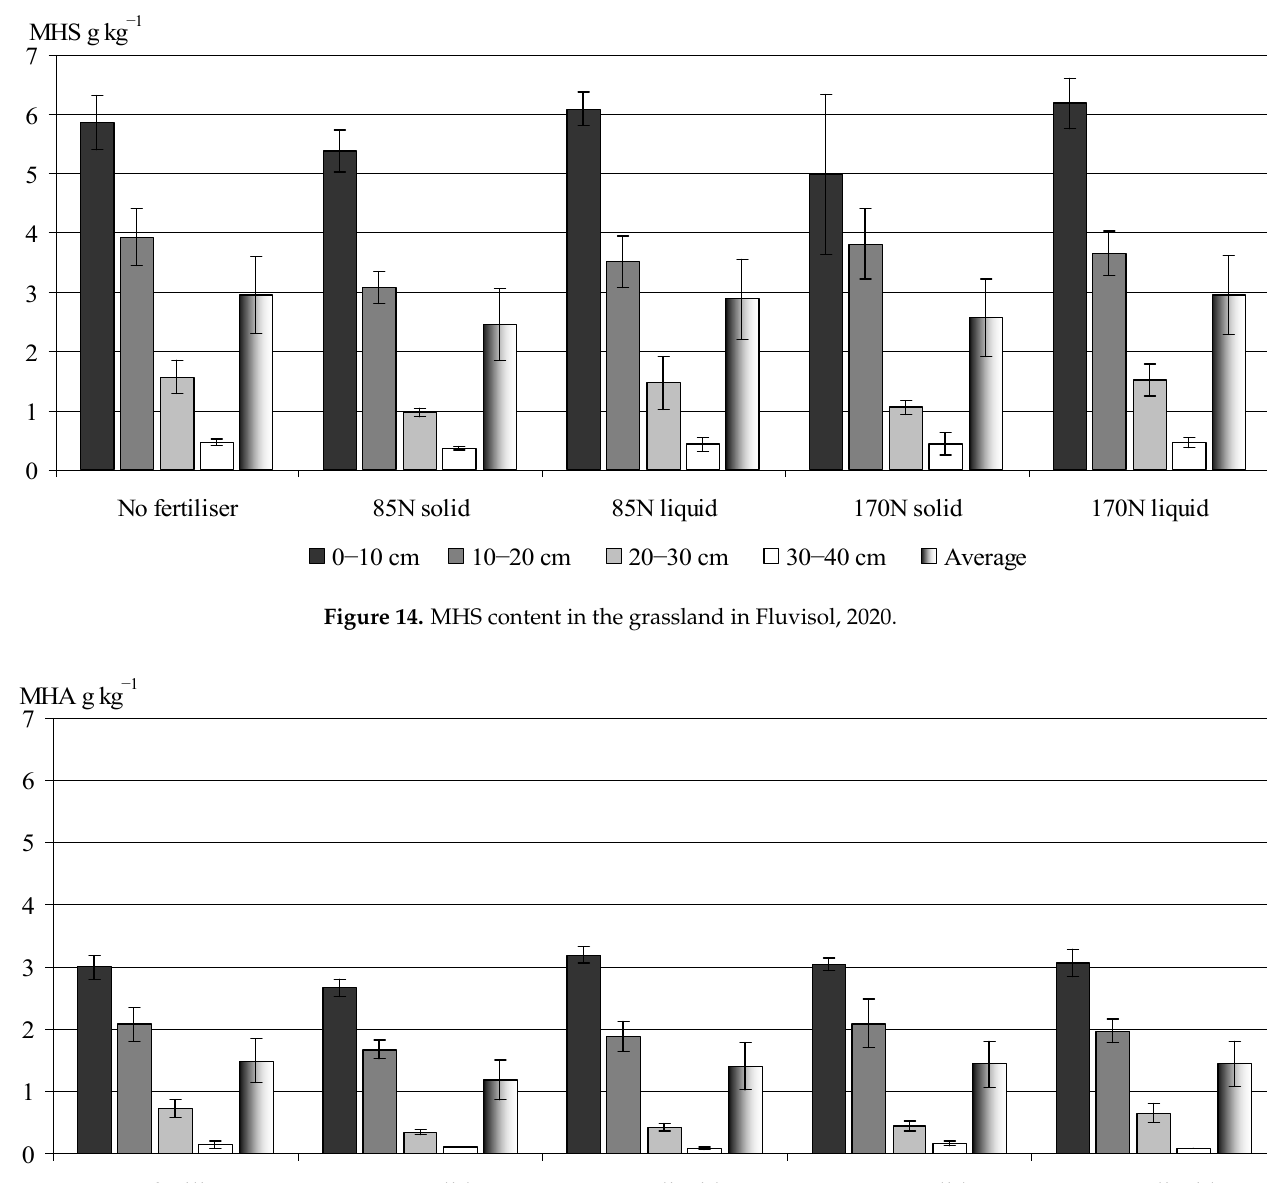
Figure 13. MHA content in the grassland in Fluvisol, 2019 .